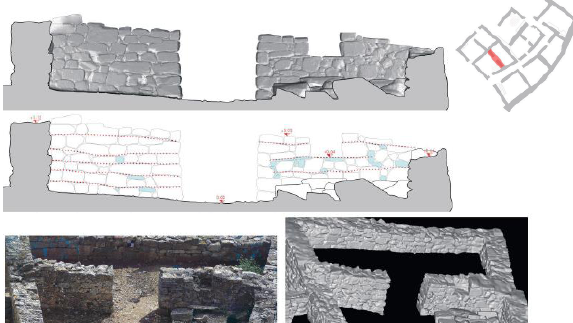
Figure 15 Masonry of type 3 a, b (Bianchi, 1995), (above) architectural vertical section (original scale 1:20) elaborated from the LiDAR and UAV integrated point clouds (centre) the technological analysis derived from Bianchi showing in red the position of lanks laying of masonry bricks and in blue are highlighted the wedge elements to regularise them.